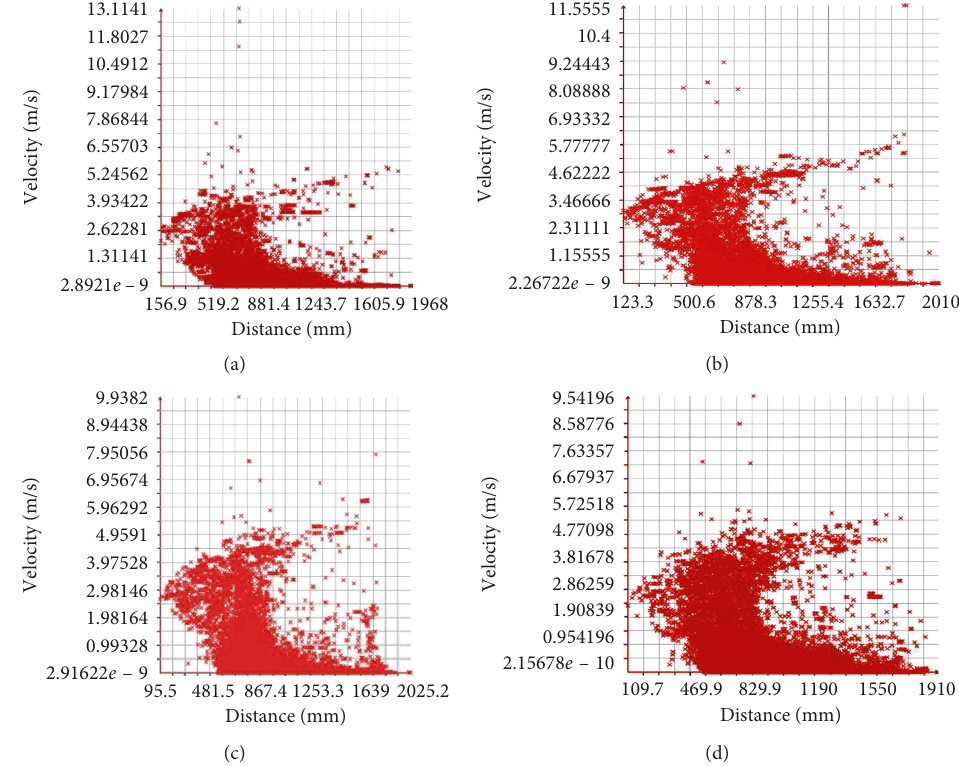
Figure 10: Distance vs. velocity of the coal particles. (a) V q (cid:31) 3 m/min. (b) V q (cid:31) 4 m/min. (c) V q (cid:31) 5m/min. (d) V q (cid:31) 6 m/min.